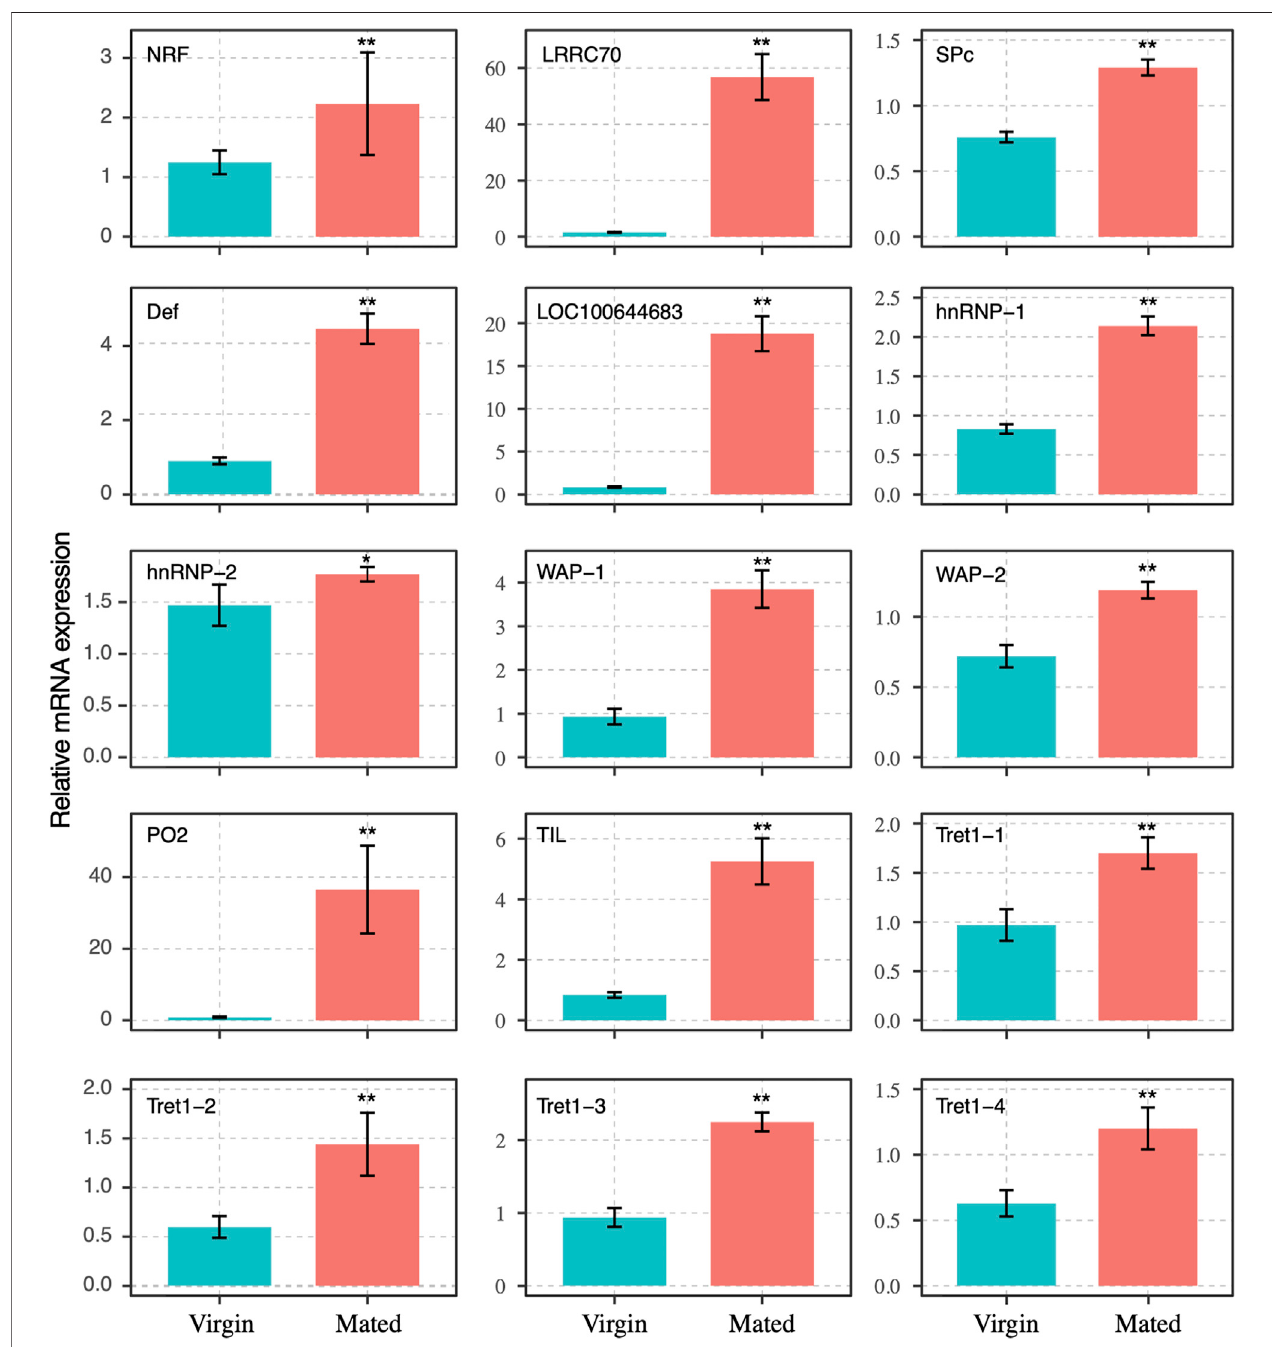
FIGURE3| Expressionpro fi leoftranscriptsthatweredifferentiallyexpressedbetweenmatedandvirginbumblebeequeensdeterminedbyRT-qPCR,at24 hpost mating. The expression levels (Mean ± SEM) of selected genes in virgin queens (blue bars) and mated queens (red bars). Asterisks indicate signi fi cant differences between the expression pro fi les of mated and virgin queens. * p < 0.05; ** p < 0.01.